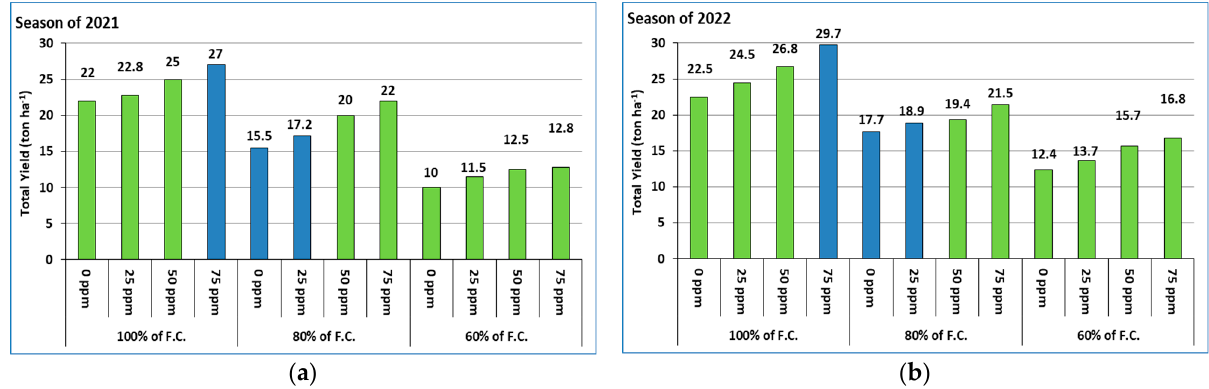
Figure 6. ( a , b ) Effect of water stress and abscisic acid on the yield of red cabbage for the 2021 and 2022 growing seasons.